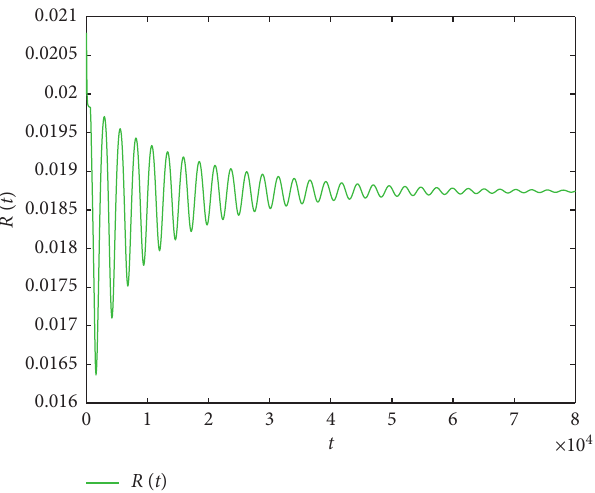
Figure 2: Time series solution of system (30) with ϕ � 0 . 90, � 728 . 403. τ � 700 < τ 0